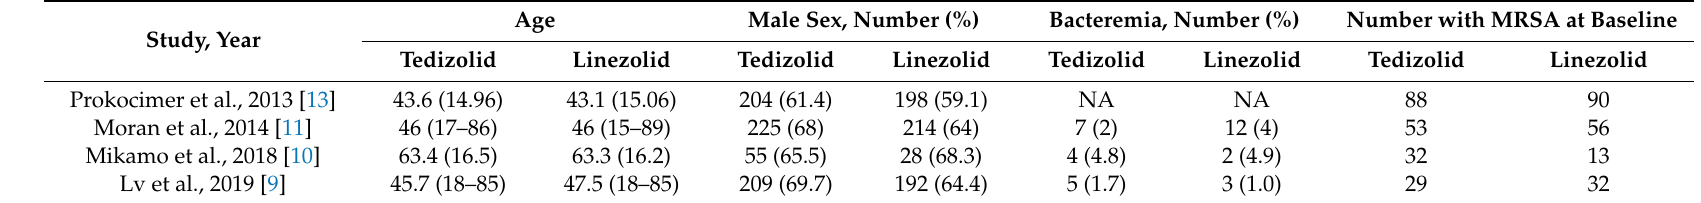
Table 2. Demographic features of enrolled cases.